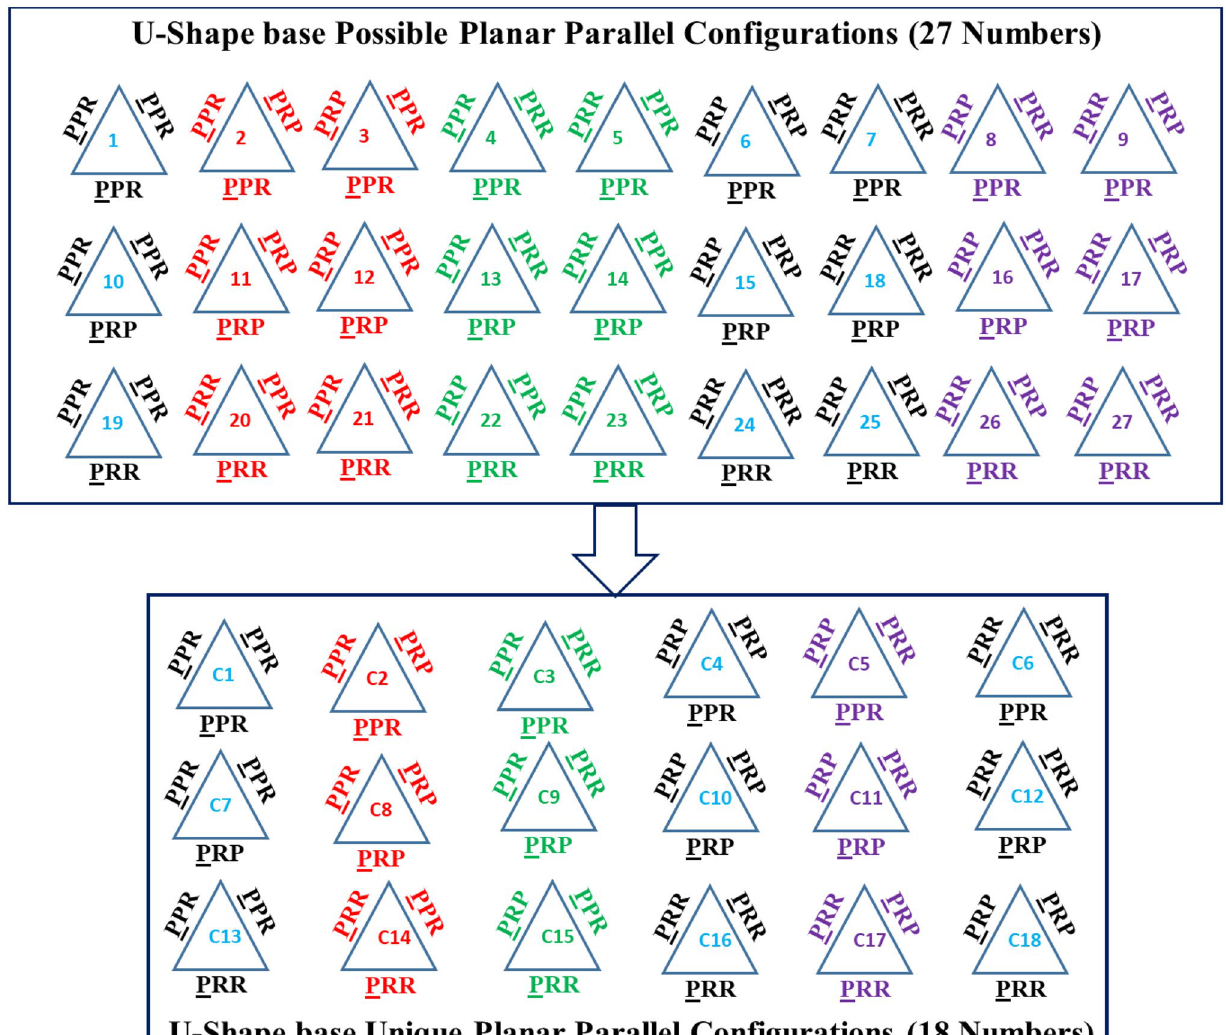
Fig. 2 Family of U-shape base planar parallel